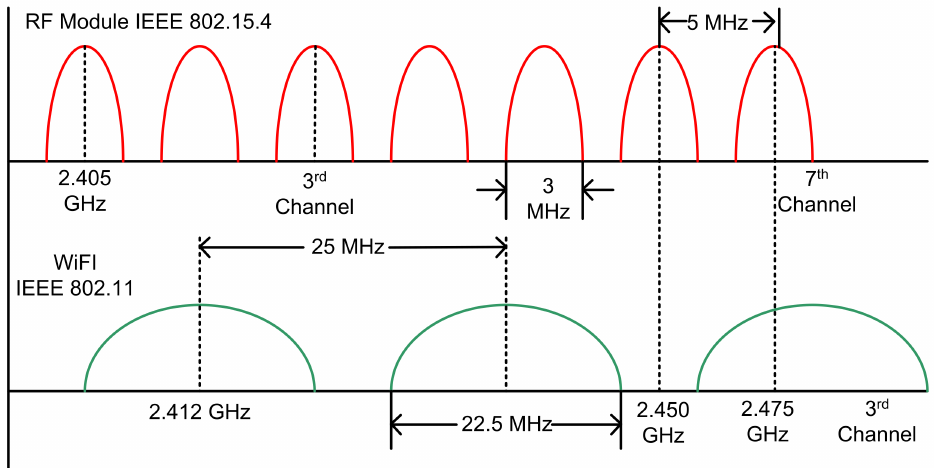
Figure 4. Radiofrequency plot of Zigbee and